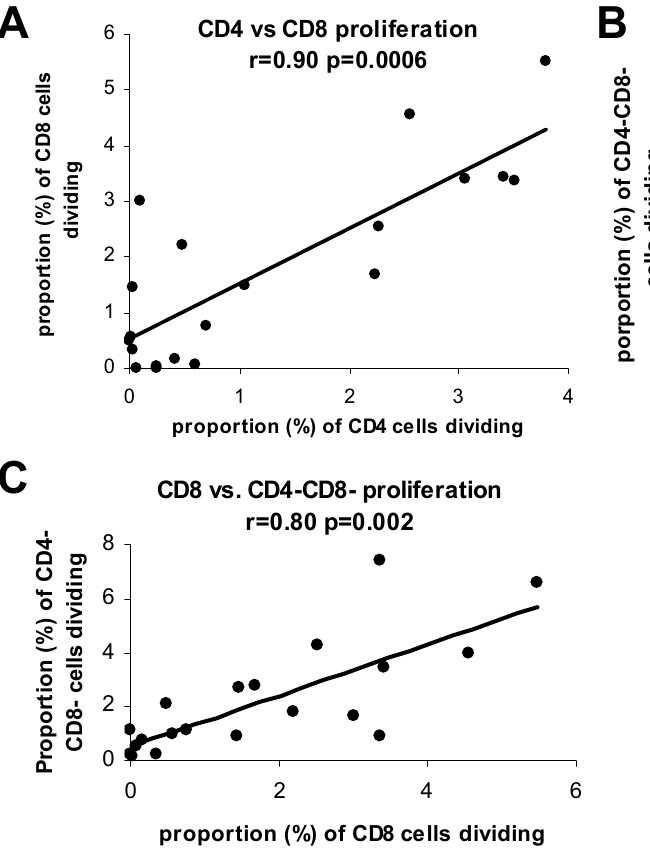
Figure 5. During mixed lymphocyte reactions soluble factors are likely involved with proliferation. Associations between CD4 T cell and CD8 T cell ( panel A ), between CD4 T cell and CD4-/CD8- cell ( panel B ), and between CD8 T cellCD4 T cell and CD4-/CD8- cell ( panel C ) proliferation as determined by CFSE dye dilution method for reactions described in Figure